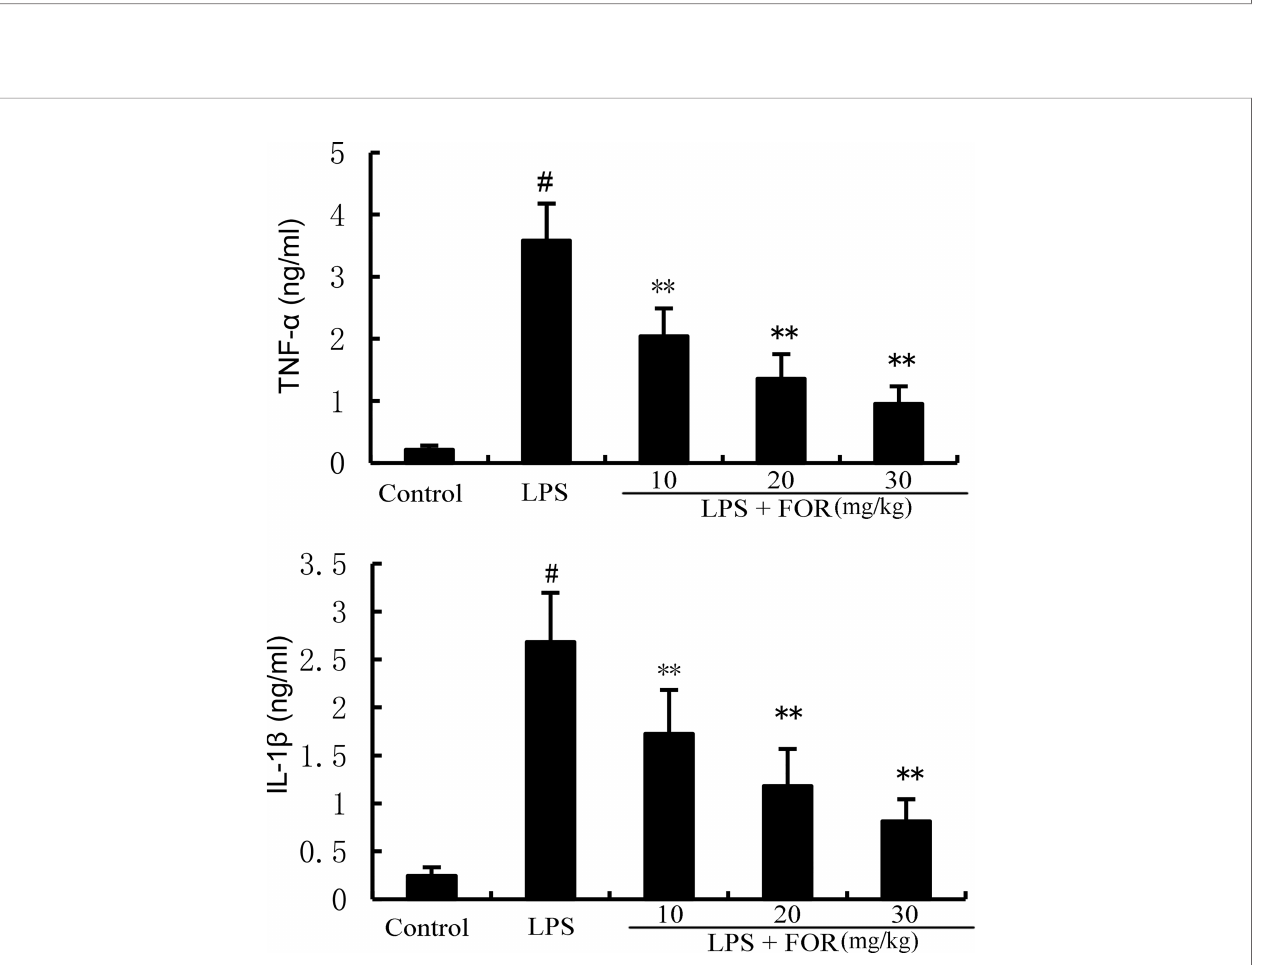
FIGURE 3 | FOR decreases LPS-induced generation of TNF- a and IL-1 b in breast tissue. The data herein are expressed as mean ± SEM obtained from triple parallel measurements. # ( P < 0.01) is signi fi cantly different from control group; **( P < 0.01) is signi fi cantly different from LPS group.